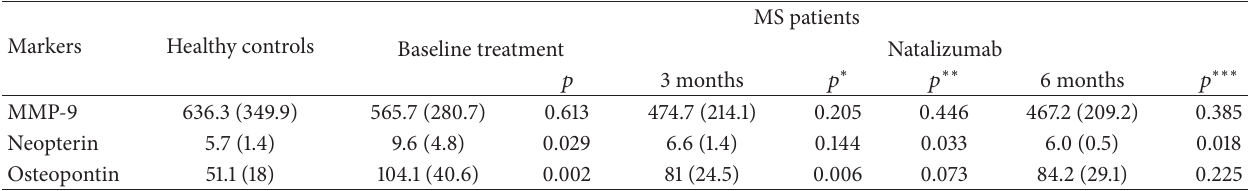
Table 1: Inflammatory